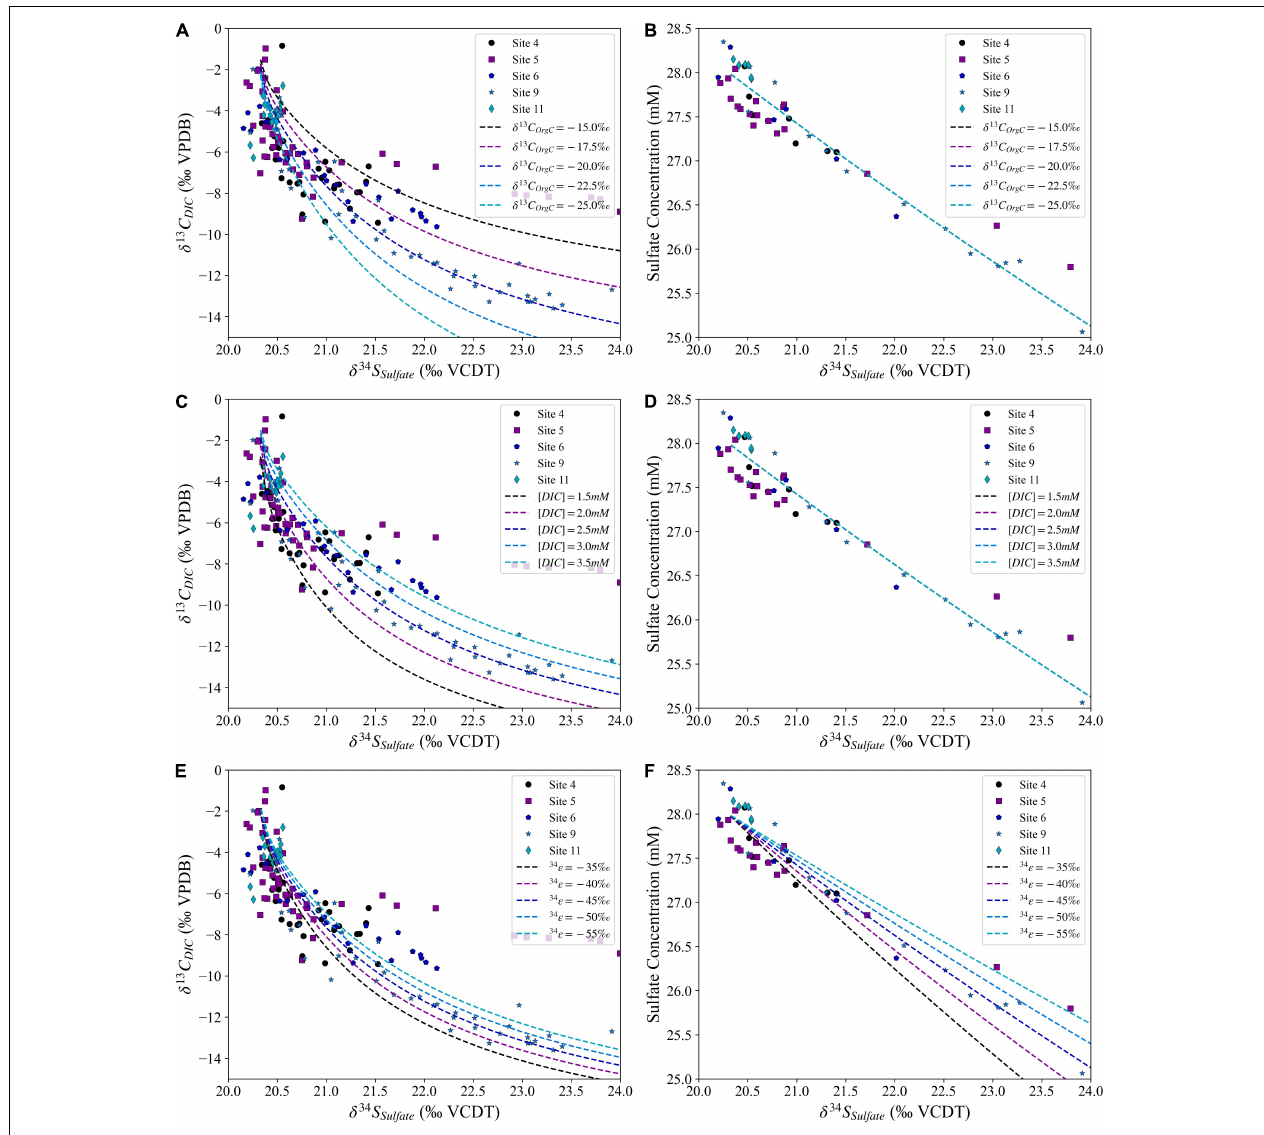
FIGURE 7 | The sulfur and carbon isotopic composition for the model with varying carbon isotope composition of the organic carbon [ δ 13 C OrgC ; (A,B) ], initial dissolved inorganic carbon concentrations [(DIC); (C,D) ] and sulfur isotope fractionation during sulfate reduction [ 34 ε ; (E,F) ] compared with the measured pore fluid values for the five sites. In panels (B,D) all five simulations are plotted; the lines are identical.